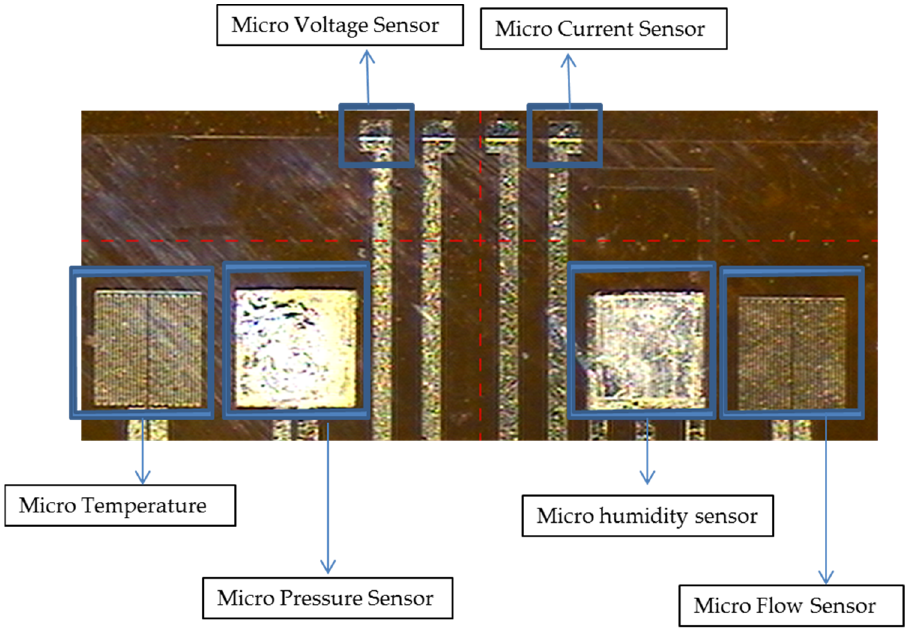
Figure 8. Optical micrograph of 6-in-1 microsensor.